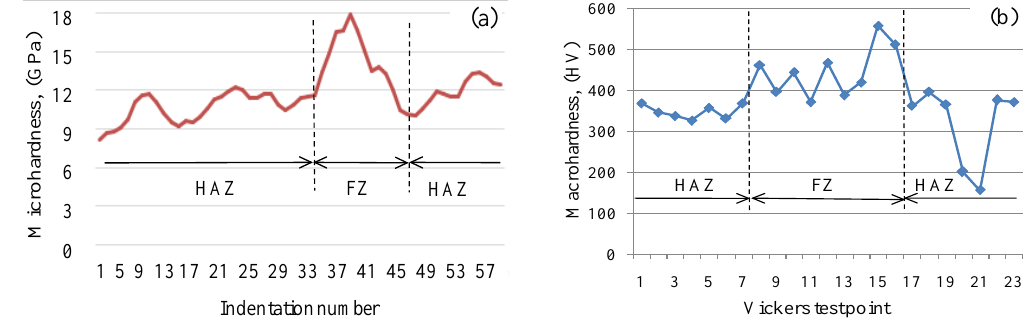
Figure 17. ( a ) Micro-indentation hardness; ( b ) measured macroscopic hardness (HAZ: Heat-affected zone; FZ: Fusion zone).